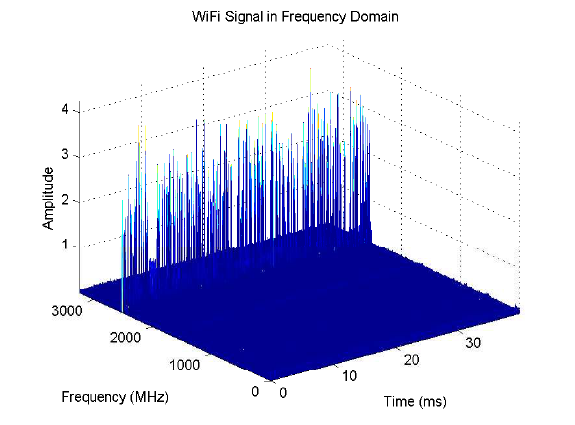
Figure 37. Time-frequency graph of measured sigals.